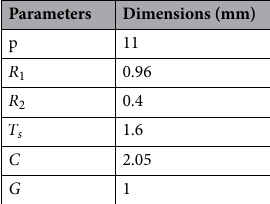
Table 1. Specification of geoemetric parameters described in Fig.